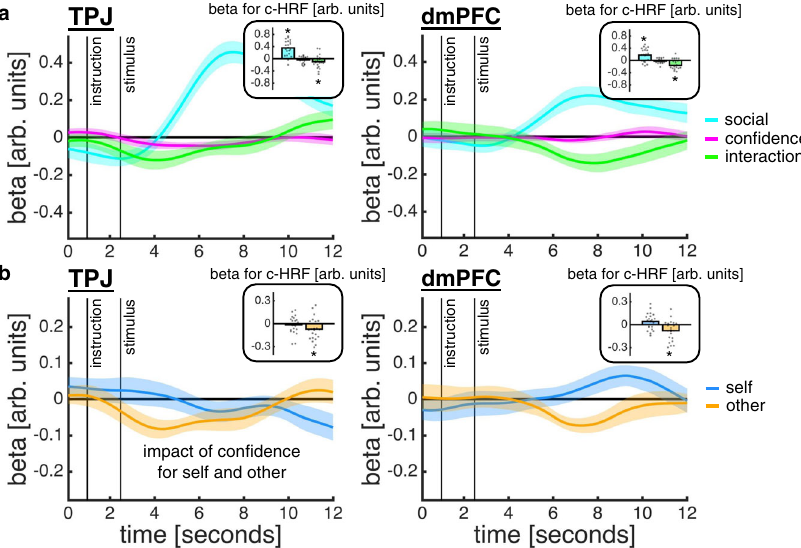
Fig. 7 TPJ and dmPFC support a social con fi dence computation. a The time courses are coef fi cients from a regression in which we predicted z-scored TPJ (left) and dmPFC (right) activity time courses using trial type (cyan; other = 0.5; self = − 0.5), z-scored model-based con fi dence estimates as computed under the ToM-model (pink; fi rst orthogonalised with respect to motion coherence) and their interaction (green). The insets show coef fi cients from an analysis of canonical HRFs (c-HRFs; asterisk indicates statistical signi fi cance, p < 0.05, one-sample t -test against zero). b Same approach as in a , but now quantifying the impact of model-based con fi dence estimates separately for each trial type. a – b Data are represented as group mean ± SEM, n = 21. Source data are provided as a Source Data fi (social; self = − 0.5 and other = 0.5), our model-based con fi dence interaction, t (20) = − 2.10, p = 0.049; dmPFC social: t (20) = estimates (as computed under the ToM-model for both self and 3.70, p = 0.001; dmPFC con fi dence, t (20) = − 1.15, p = 0.264; other) and the interaction between these terms. To control for dmPFC interaction, t (20) = − 3.44, p = 0.003). However, the nature low-level sensory effects, we orthogonalised the model-based of the interaction effect differed between regions (Fig. 7b). In con fi dence estimates with respect to motion coherence. support of selectivity for social inference, TPJ encoded the model- This analysis showed that both TPJ and dmPFC encoded an based con fi dence estimates on other-trials only, with higher activity interaction between trial type and the model-based con fi dence when con fi dence was low (c-HRF regression; con fi dence on other- estimates (Fig. 7a; c-HRF regression; TPJ social: t (20) = 6.33, trials, t (20) = − 2.17, p = 0.043; con fi dence on self-trials, t (20) = − 0.60, p = 0.555). By contrast, dmPFC encoded model-based p < 0.001; TPJ con fi dence, t (20) = − 1.79, p = 0.089; TPJ